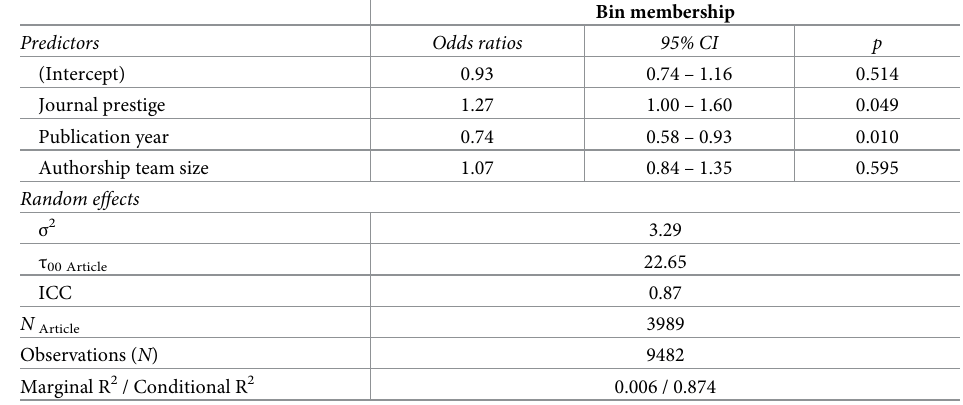
Table 8. Multilevel logit regression results for predictors of bin membership (substantive database; 15 relation types combined).